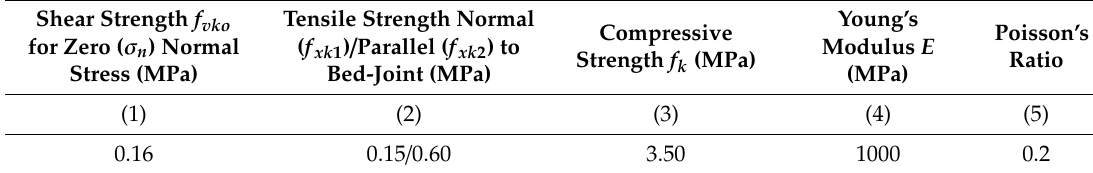
Table 2. Assumed Mechanical Characteristics of the Stone Masonry in N / mm 2